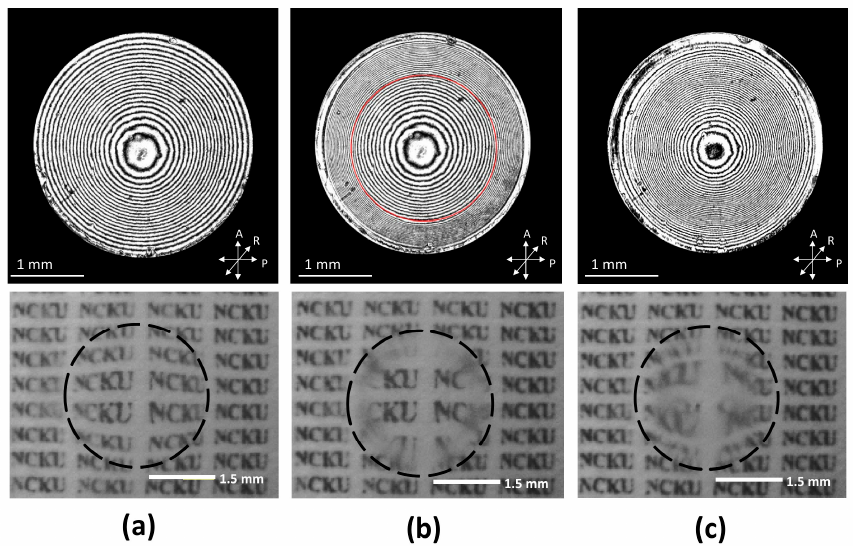
Figure 8. Interference patterns and imaging performance of the TLCL lens with electrically switching modes of coaxial bi-focus and single focus: individually operating at voltages of: ( a ) 10 V rms ; ( b ) 50 V rms ; ( b ) 100 V rms . The black dash circles indicate the boundary of the lens aperture.